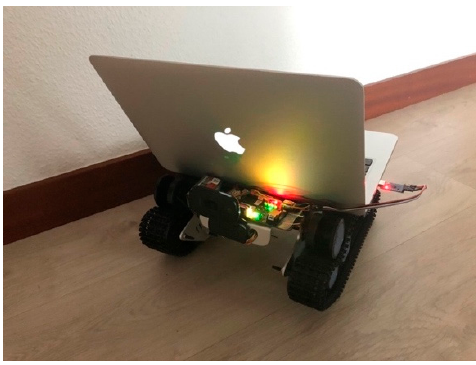
Figure 8. The Autonomous Mobile Robot used in the current work.